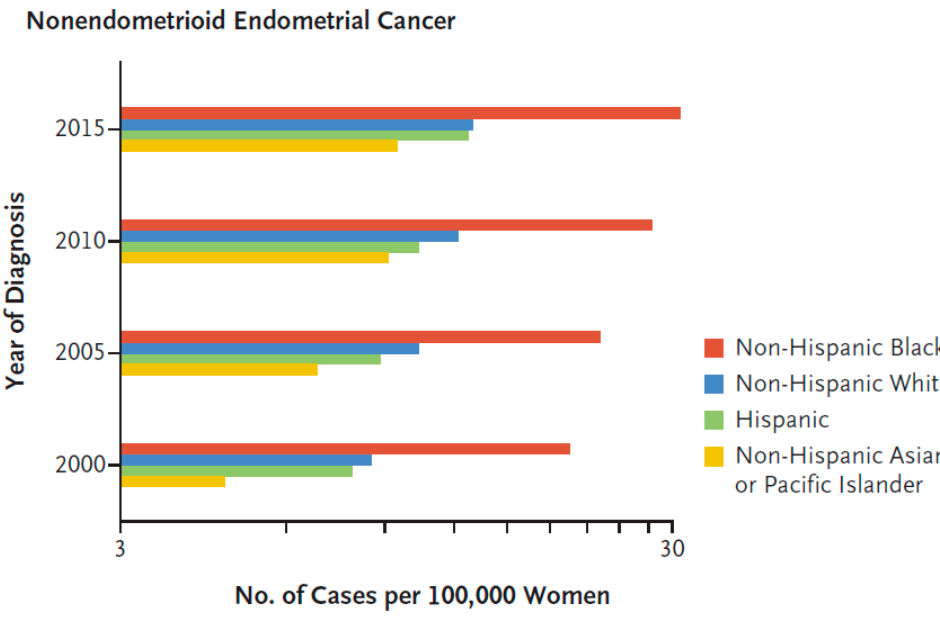
Figure 2. Age-adjusted and hysterectomy-corrected incidence of nonendometrioid endometrial cancer according to race [15]. Reproduced with permission from Massachusetts Medical Society.